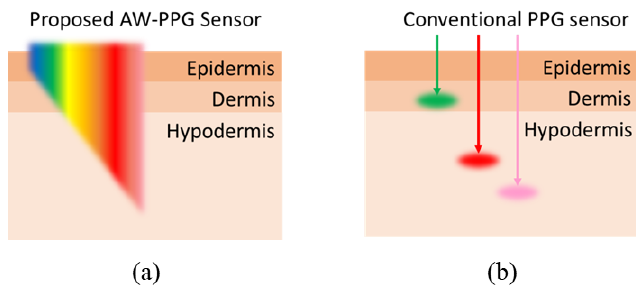
Figure 2. Illustration of sensing ability of all-wavelength photoplethysmography (AW-PPG) sensors against conventional PPG sensors: ( a ) AW-PPG sensors; ( b ) Conventional PPG sensors.